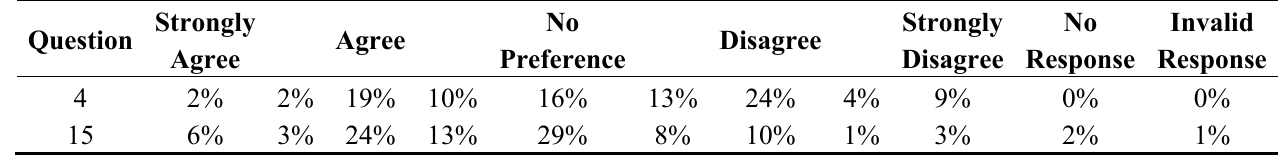
Table 19. Comparison of Question 4 and 15 responses.